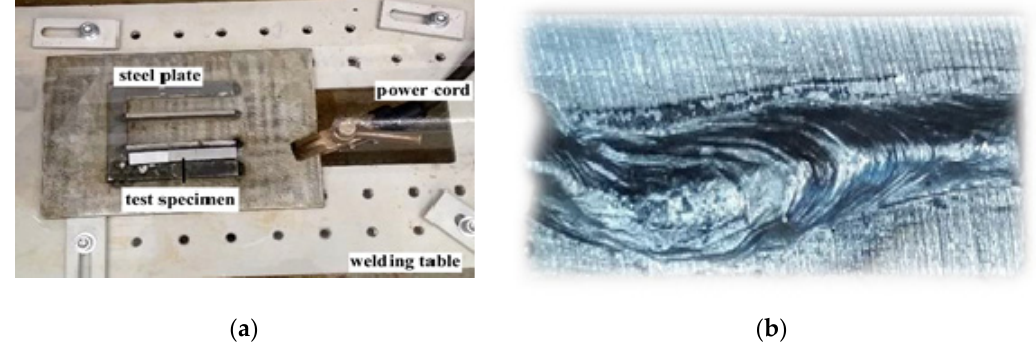
Figure 5. ( a ) The location of specimen for welding; ( b ) View of specimen after welding.